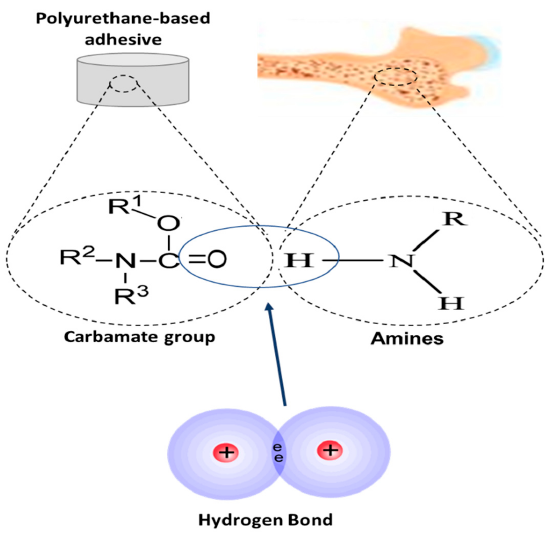
Figure 7. Chemical and/or physical bonding of polyurethane-based adhesives with bone. Hydrogen bonding occurs between the carbamate group of adhesive system and the amines present in bone collagen matrix.